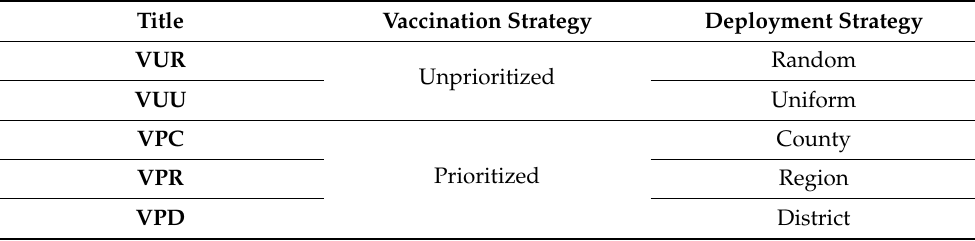
Table 3. The spatial vaccination strategies and corresponding